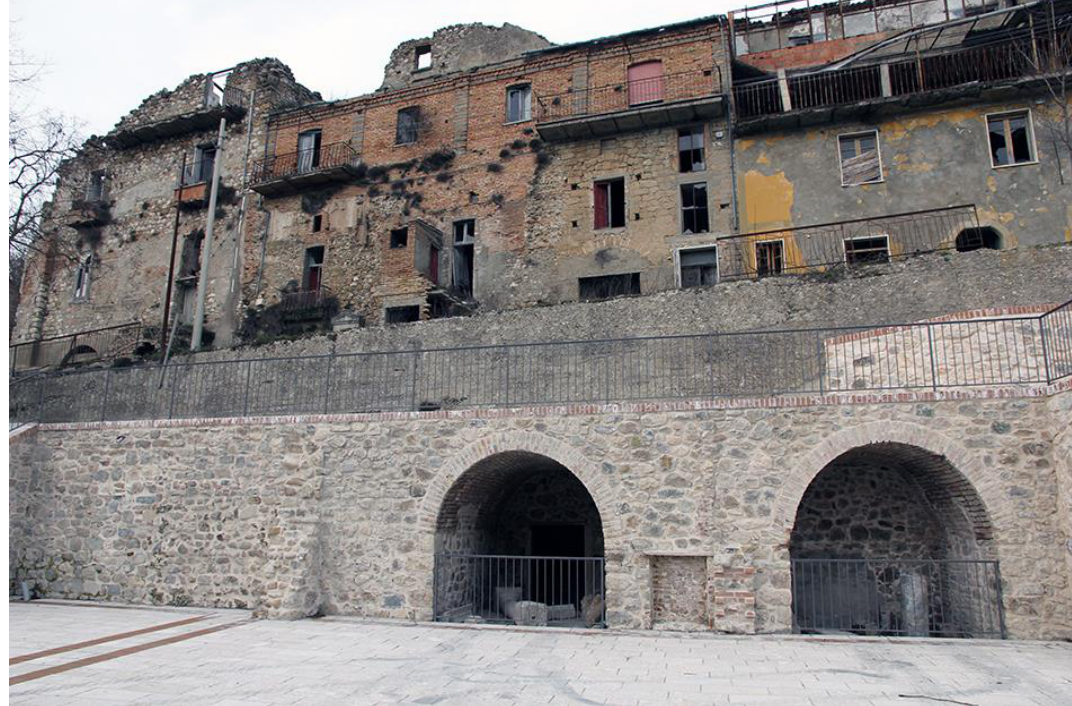
Figure 12. Conza della Campania: old village with ruins of houses after the 1980 earthquake (photos by [35,36]).